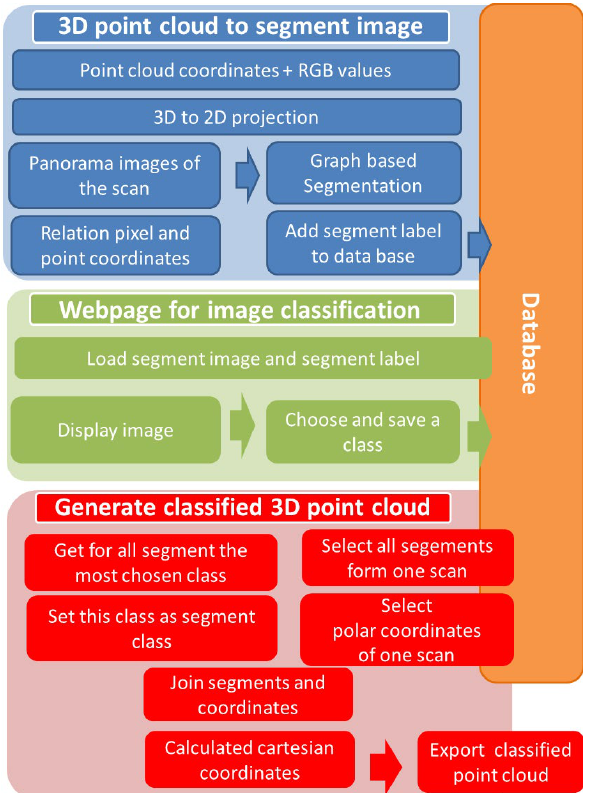
Figure 3. Workflow and main modules of